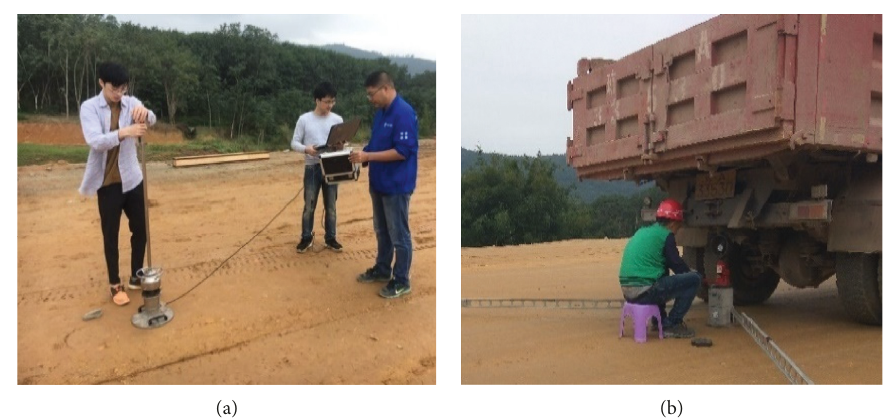
Figure 3: Field tests on the trial embankment of Wanning-Yangpu highway. (a) PFWD test. (b)